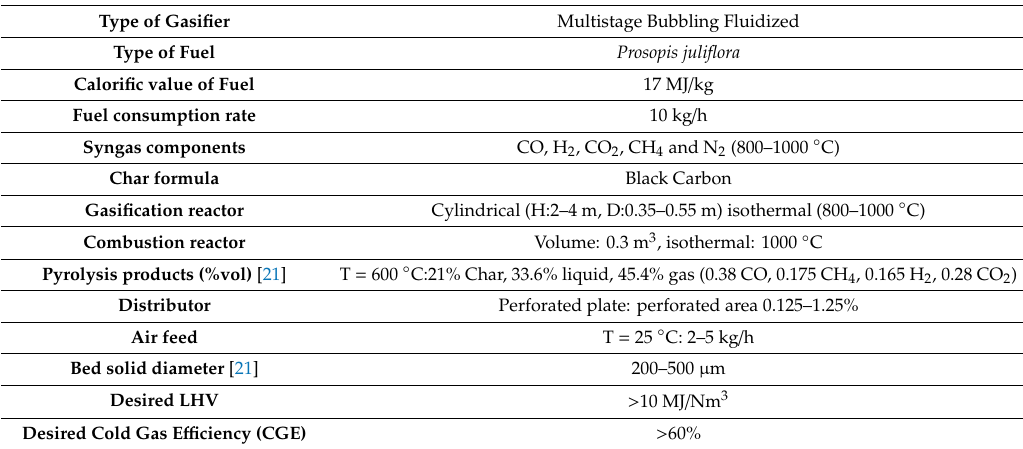
Table 1. Assumptions and Desired Design